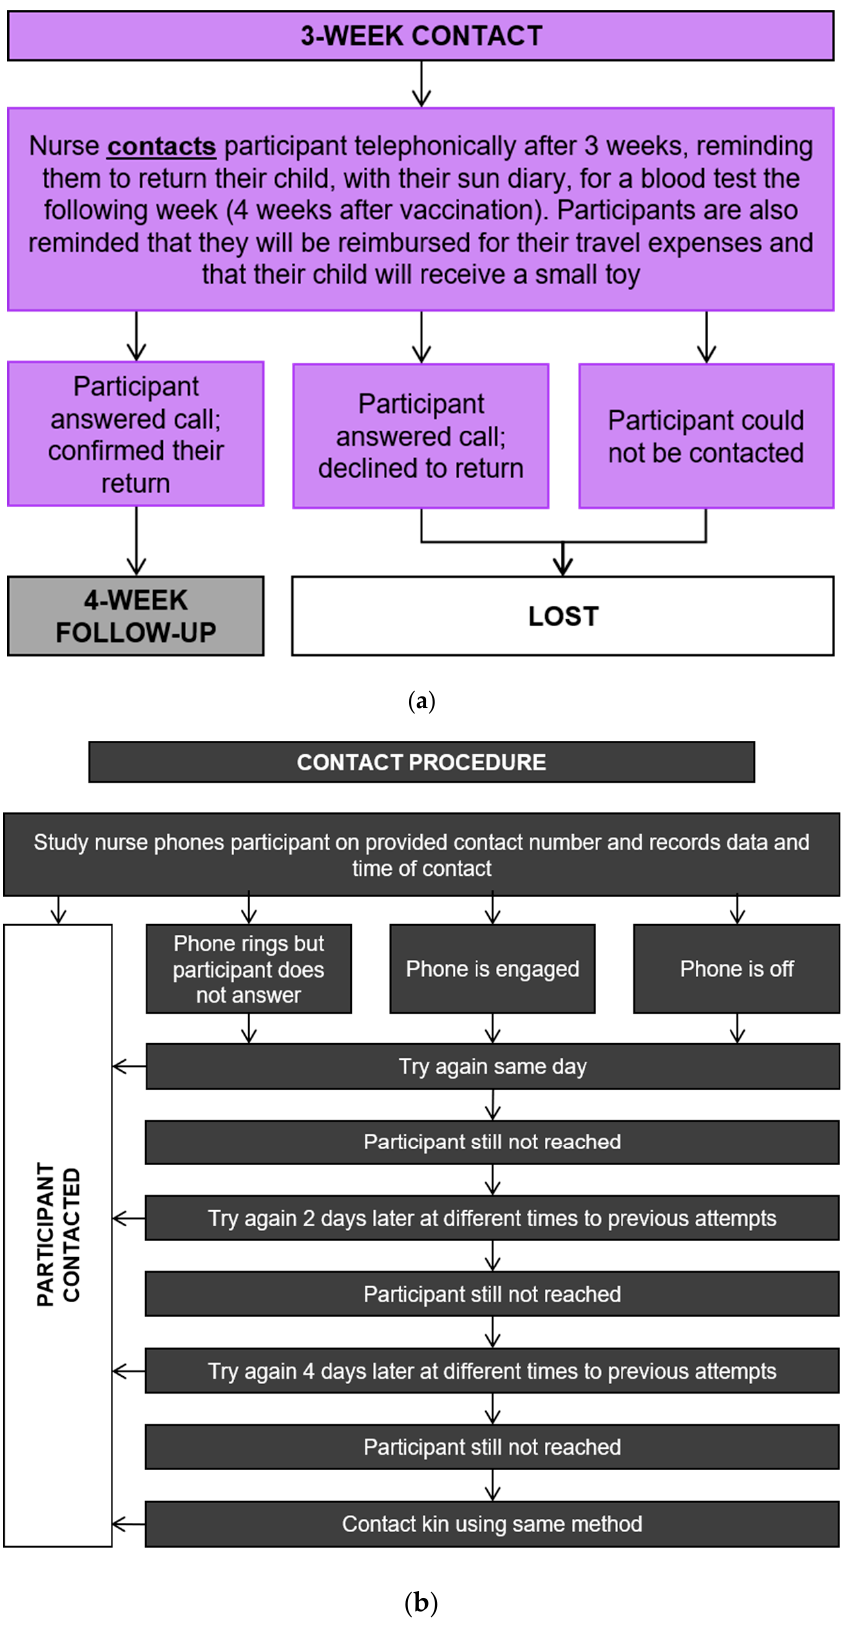
Figure 6. ( a ) Three-week contact process and ( b ) contact procedure.